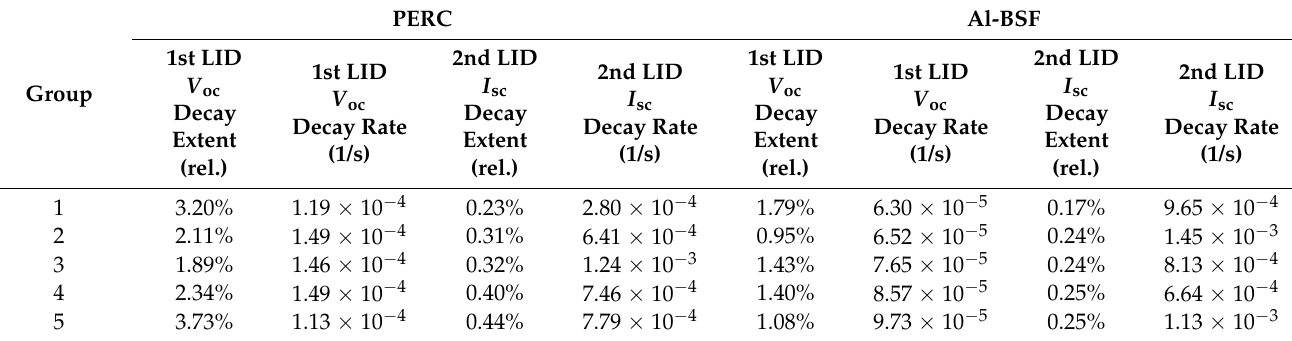
Table 2. Relative decay extent and decay rate of V oc during the first LID and those of I sc during the second LID for five groups of PERC and Al-BSF